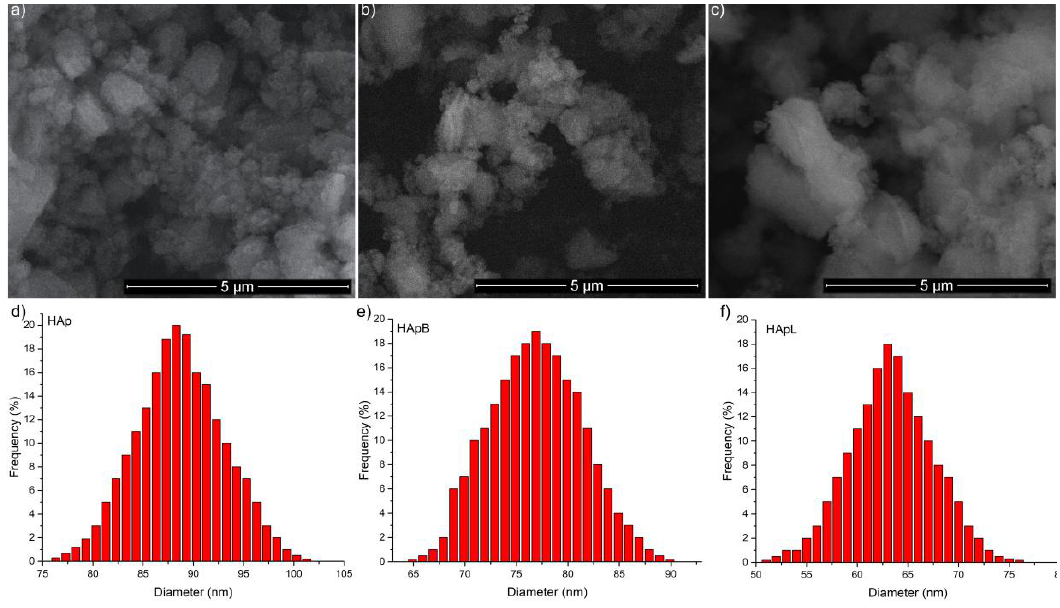
Figure 2. Scanning Eelectron Microscopy (SEM) images of the HAp ( a ), HApB ( b ) and HApL ( c ) samples. Size distributions of HAp ( e ), HApB ( f ) and HApL ( g ) samples. ( c ) samples. Size distributions of HAp ( e ), HApB ( f ) and HApL ( g )